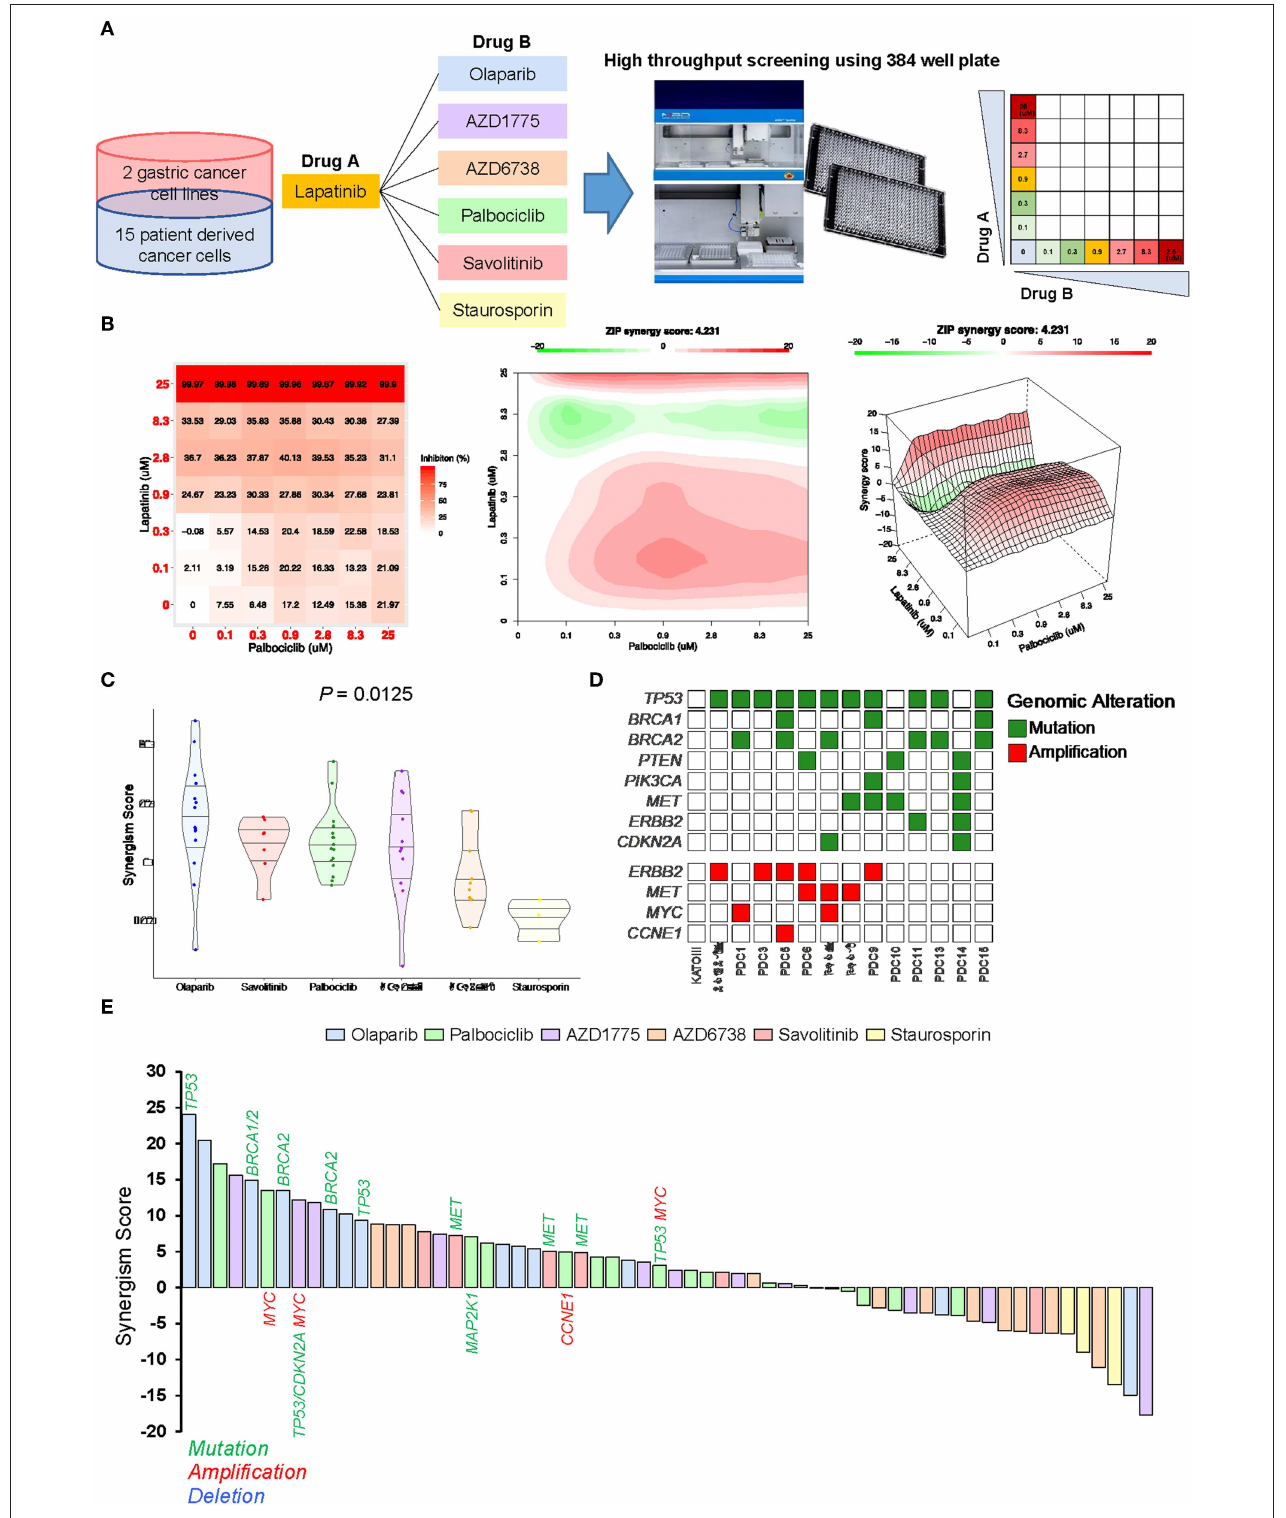
FIGURE 4 | Systematic evaluation of two-drug combination therapy in gastric PDCs (A) Representative overview of systematic evaluation of two-drug combination therapy for lapatinib with olaparib, AZD1775, AZD6738, palbociclib, savolitinib, or staurosporin. (B) Dose-response matrix for two-drug combination (left panel) and2D(middlepanel)and3D(rightpanel)synergymaps. (C) Representativeviolinplotsforsynergismscoresforrespectivedrugcombinations.Horizontallineswithinthe